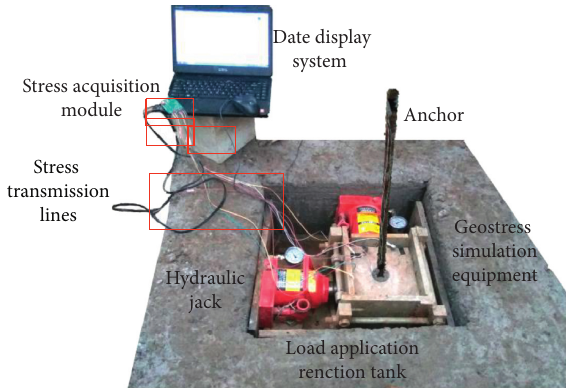
Figure 2: Device diagram of rock mass anchoring under ground stress.